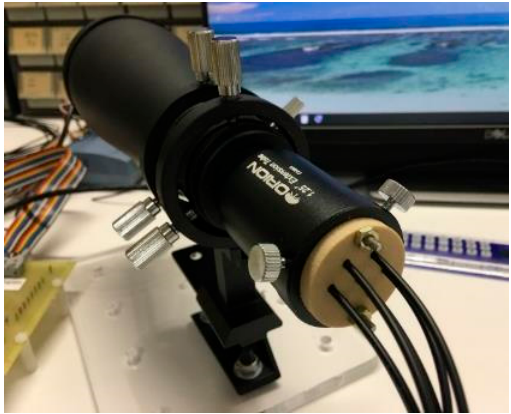
Figure 4. Sensor head installed in Orion 70 mm Multi-Use Finder Scope with fiber optic guides exiting the rear.